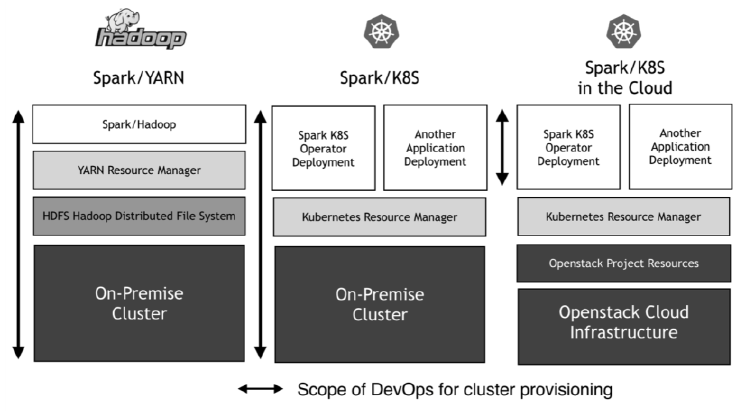
Figure 7: Top level comparison of Spark